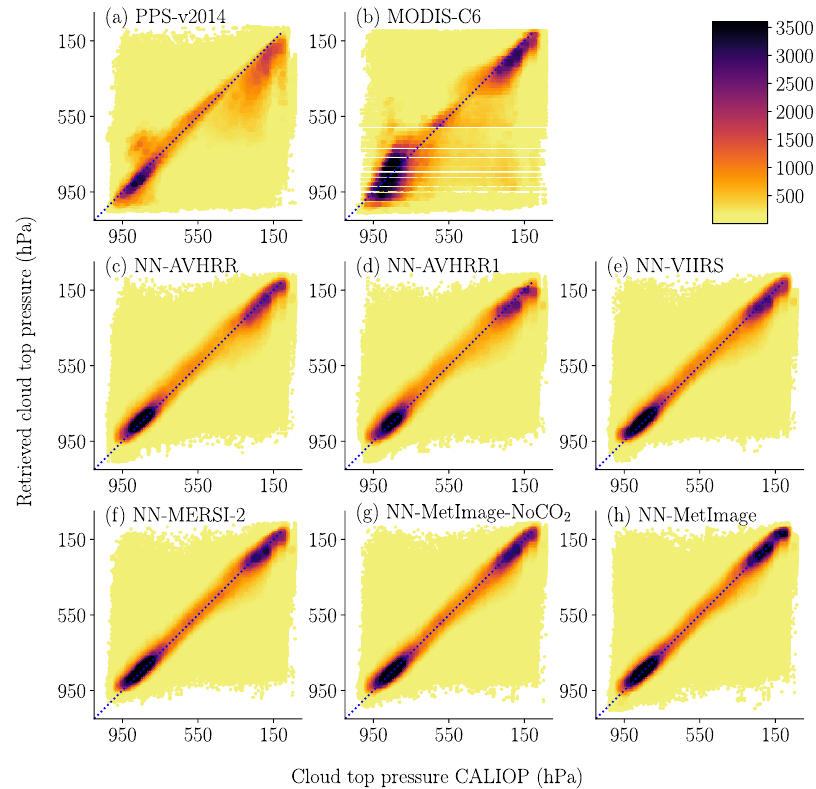
Figure 1. Scatter plots of the pressure for the neural networks and for the reference methods against CALIOP cloud top pressure. The data were divided in 10 × 10(hPa) bins for color coding. The number of points in each bin determines the color of the point. The final validation dataset (see Table 1) where all algorithms had a height reported is